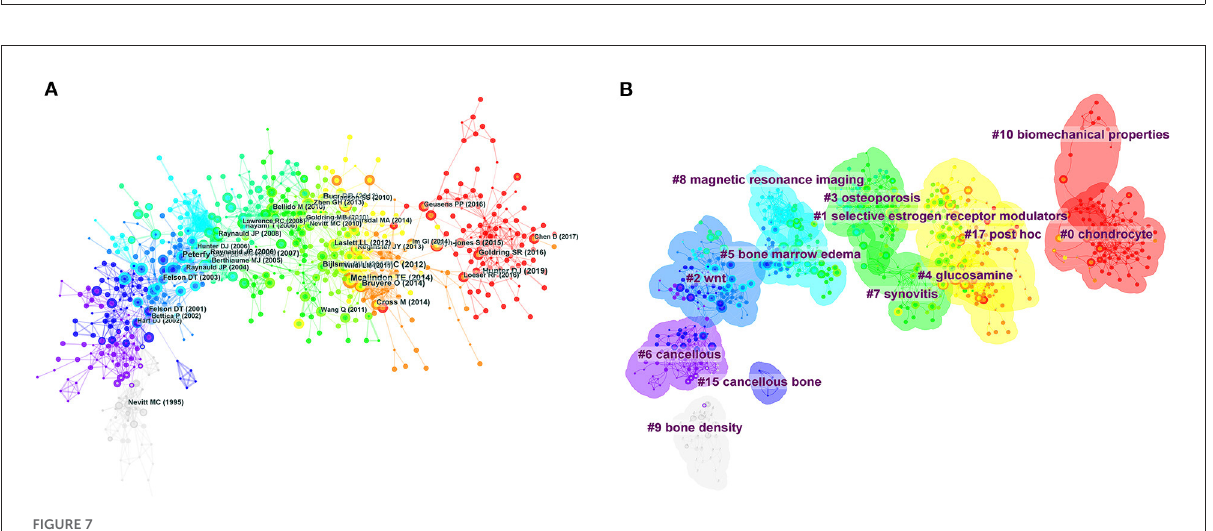
showing a high negative correlation (52). These suggested that assessment of subchondral BMD in the medial tibial plateau may be a good predictor of the degree of medial space